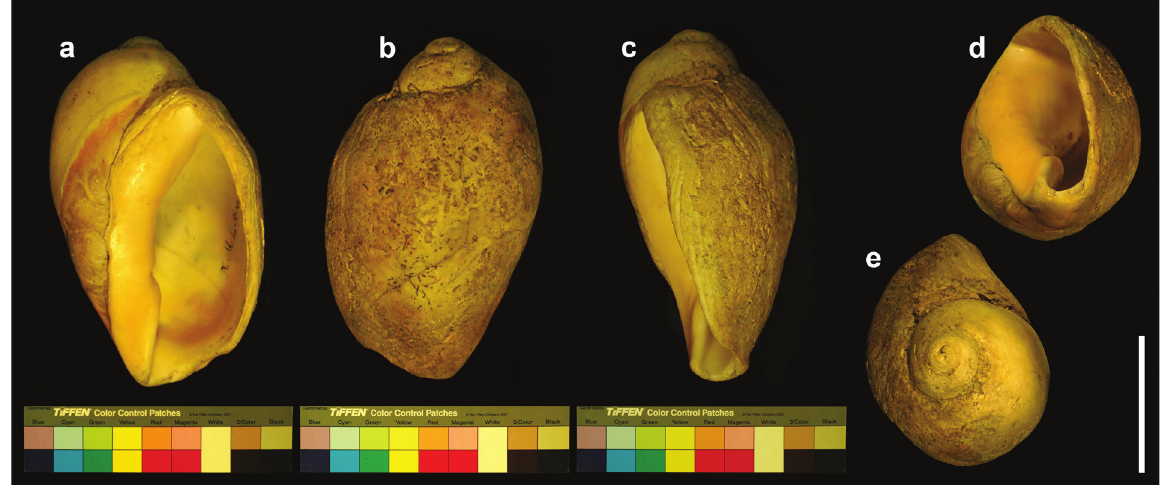
Figure 44. Voluta oviformis typica , specimen figured by Lahille (1895: pl. X, fig. 6). a Apertural view b Dorsal view c Lateral view d Umbilical view e Apical view. Scale bar: 5 cm.